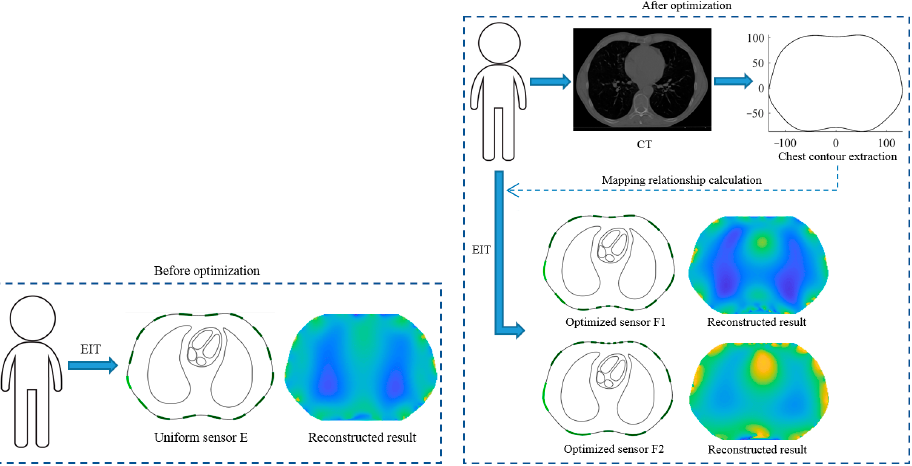
Figure 1. Thoracic EIT measurement process and simulation results before and after optimization.